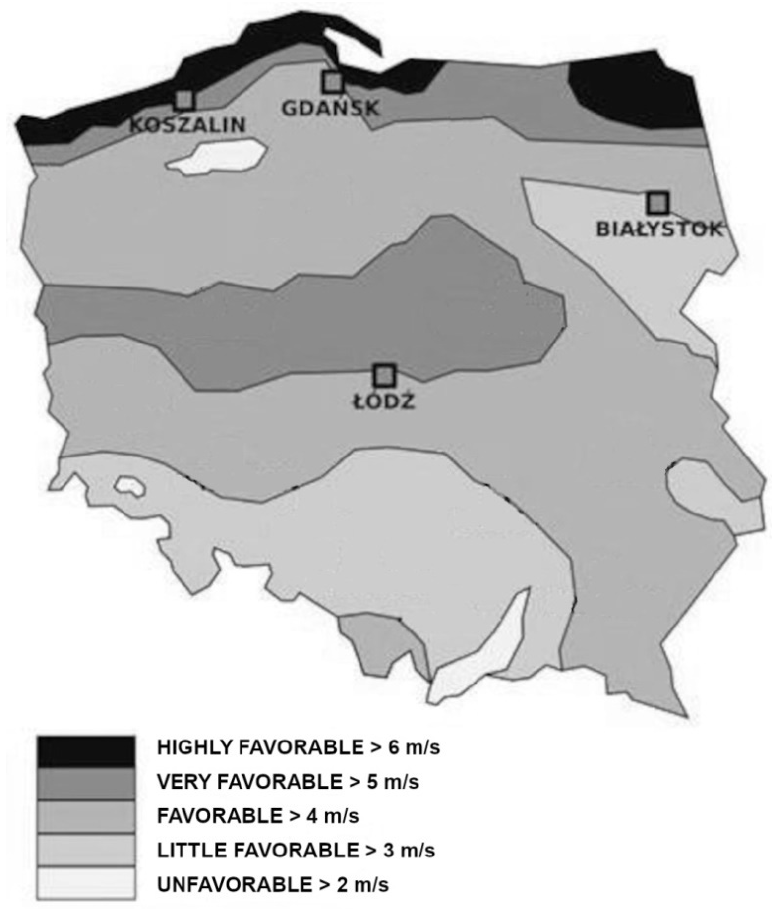
Figure 1. Wind energy zones in Poland and analysis sites. Wind speed distribution depends to a high degree on local topographic and urban conditions. Architectural barriers that disrupt wind flow create “roughness” in the land sur- face. The reduction in wind speed is smallest over the surface of large bodies of water and greatest in densely developed urban areas. Wind flowing through an open area approaches the boundaries of the built-up area and encounters resistance caused by buildings. This resistance reduces the wind flow speed at the usable level of the urban area, which forms a disturbed transition zone between the ground and the undisturbed wind flow over the city. Near the ground, the wind experiences friction. Its speed is drastically reduced and flow turbulence increases [16–18]. The state of windiness in an urban area is a major factor affecting the living comfort of residents. Wind conditions in an urban area determine build- ing ventilation, air purification, heat transfer through the wall barriers, and rain flooding of wind-exposed facades. Strong urban wind causes discomfort among pedestrians, especially in colder seasons [17–24]. Therefore, urban planners, when designing land use, are mainly guided by the criterion of residents’ comfort. Concurrently, they affect the reduction of wind speed in the city, which hinders the utilization of wind energy potential in the urban area. Air movement velocity at street level and wind turbulence conditions depend